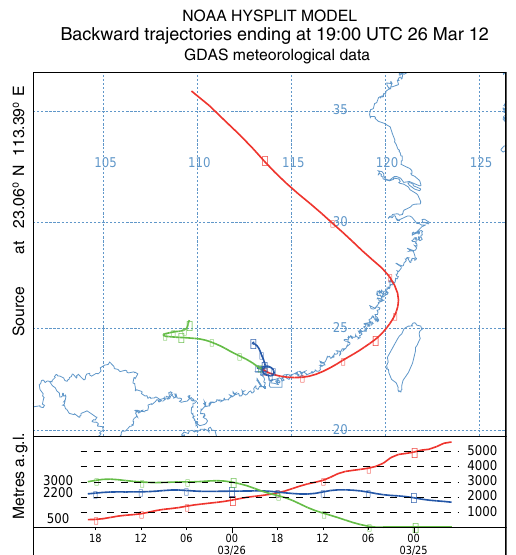
Figure 4. Trajectory analysis for 26 March 2012, 48h back in time, arriving at 500m inside the boundary layer, at 2200m below the lofted layer, and at 3000m inside the lofted layer.